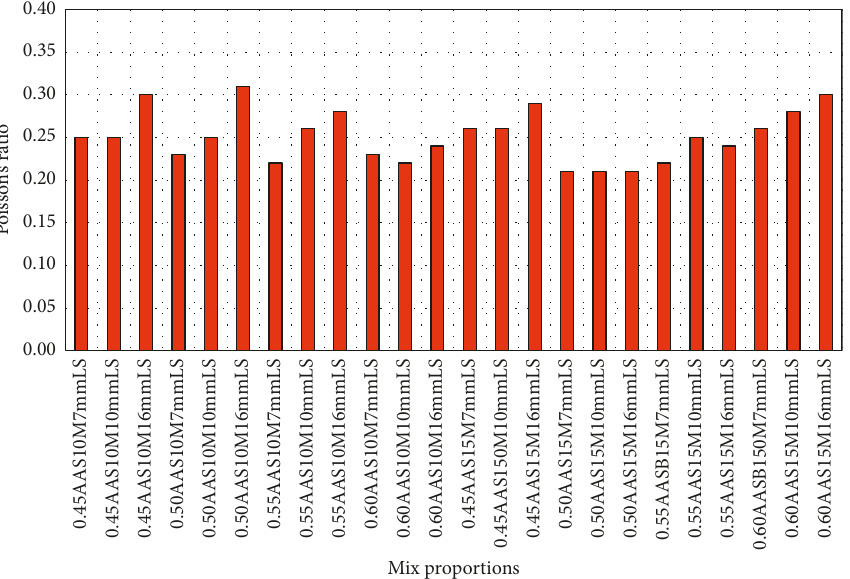
Figure 10: 28-day Poisson’s ratio of the